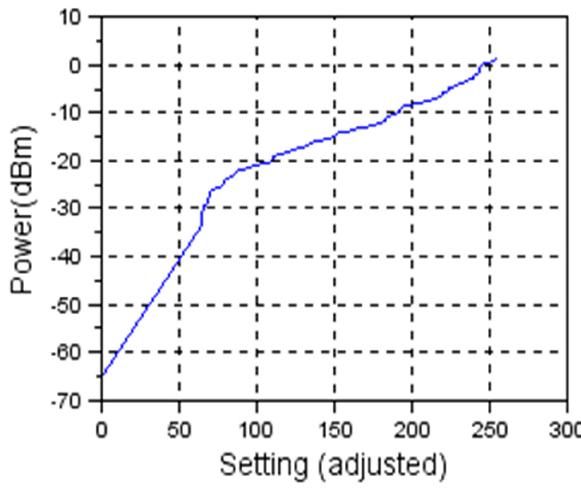
Figure 9. Linearization of transmission power level vs. register setting.